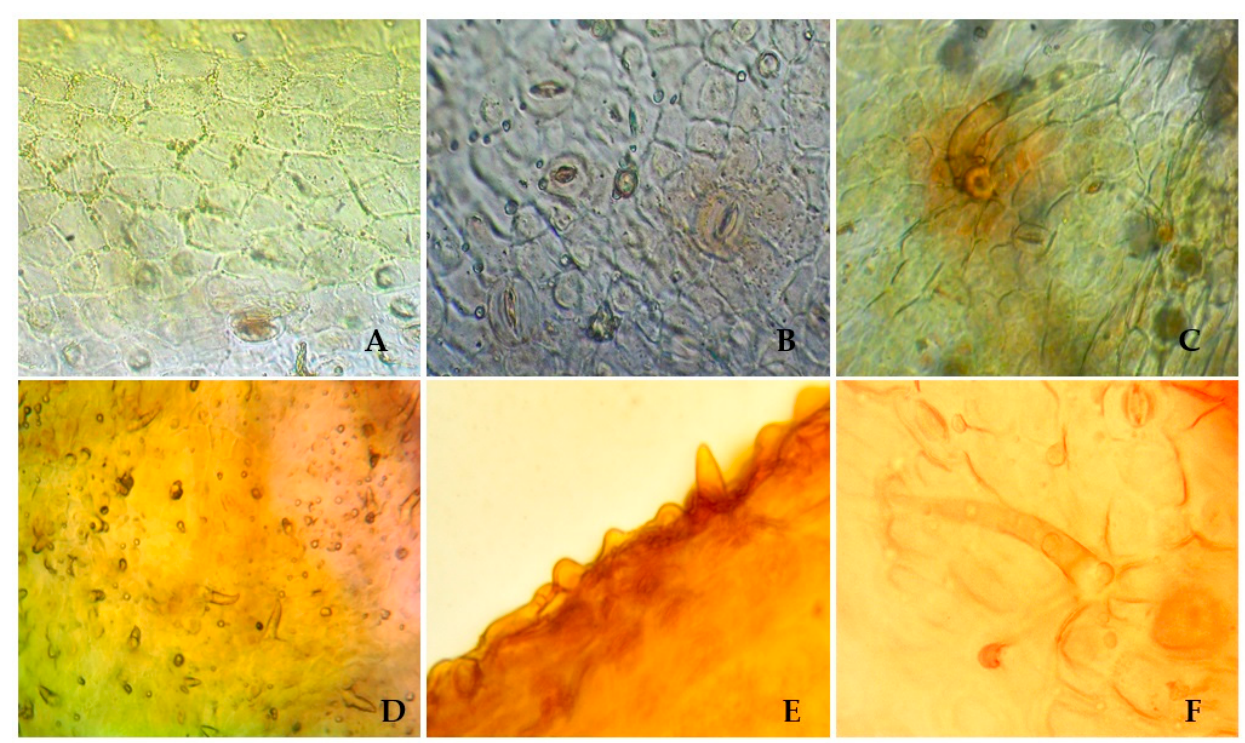
Figure 1. S. hypericifolia leaves. A . The upper epidermis of the leaf blade (×400) B . The lower epi- dermis of the leaf blade (×400) C . The epidermis of the leaf blade with a single one-celled trichome epidermis of the leaf blade ( × 400) ( C ). The epidermis of the leaf blade with a single one-celled and anomocytic stomata (×600). D . Ordinary one-celled sharp conical trichomes (×600). E . Wrinkled trichome and anomocytic stomata ( × 600). ( D ). Ordinary one-celled sharp conical trichomes ( × 600). cuticula with nodi (×600). F . An ordinary hair and its attachment site (×600). ( E ). Wrinkled cuticula with nodi ( × 600). ( F ). An ordinary hair and its attachment site ( × There is not much information about the anatomical features of the leaves of S. hy-